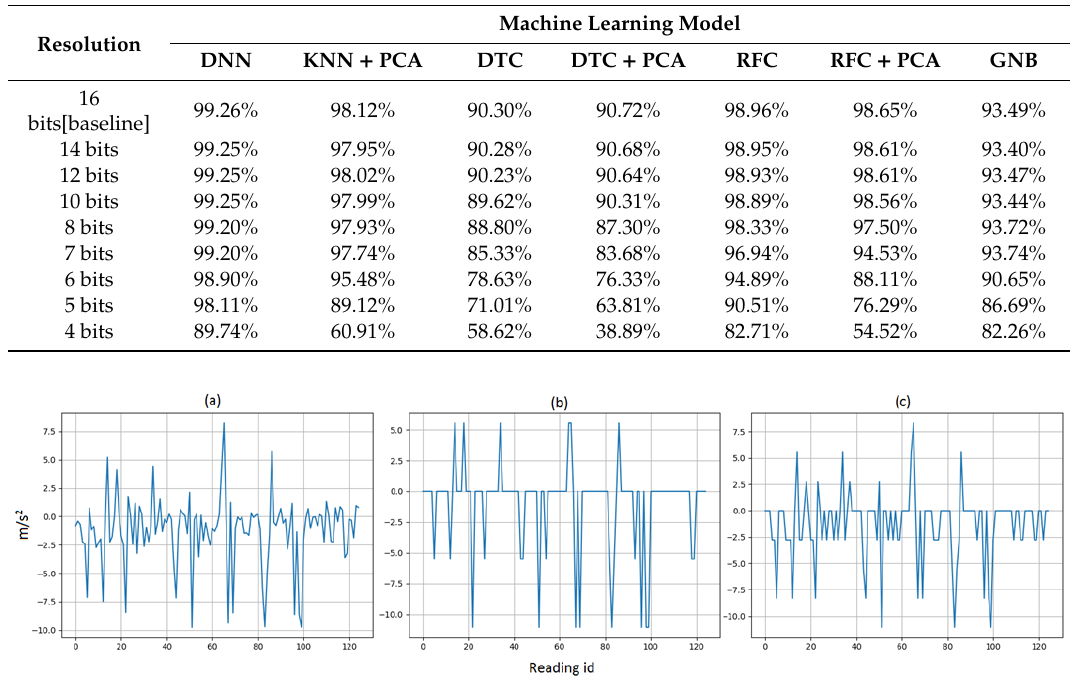
Table 3. Average inference accuracy using low resolution inference accuracy.